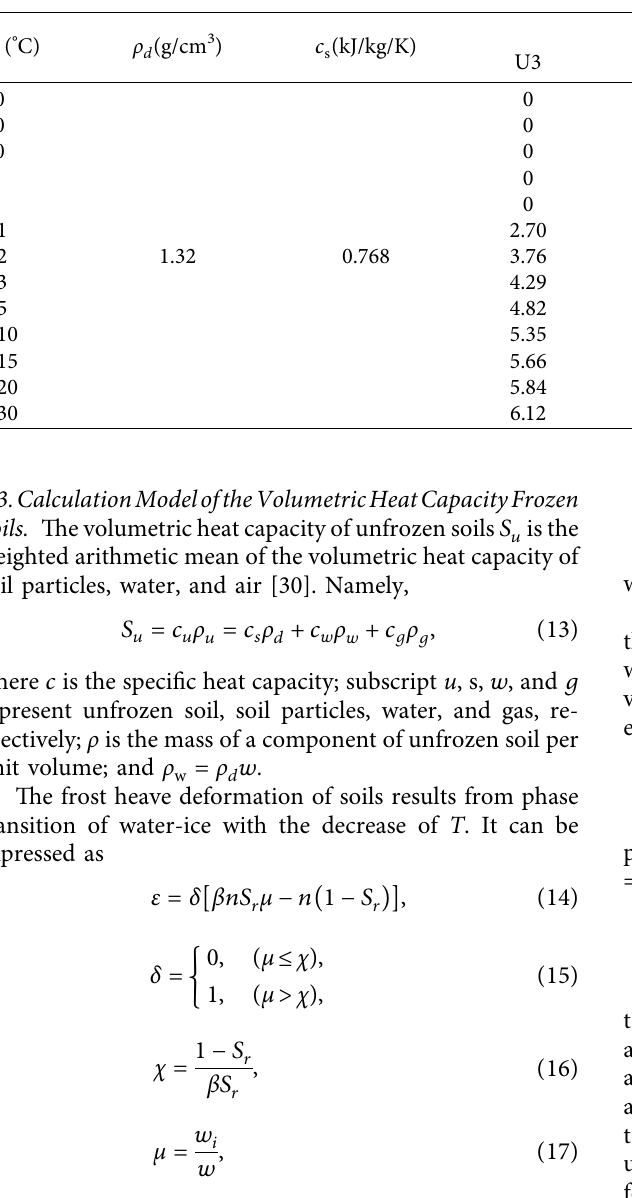
Table 3: Thermal conductivities of the soil